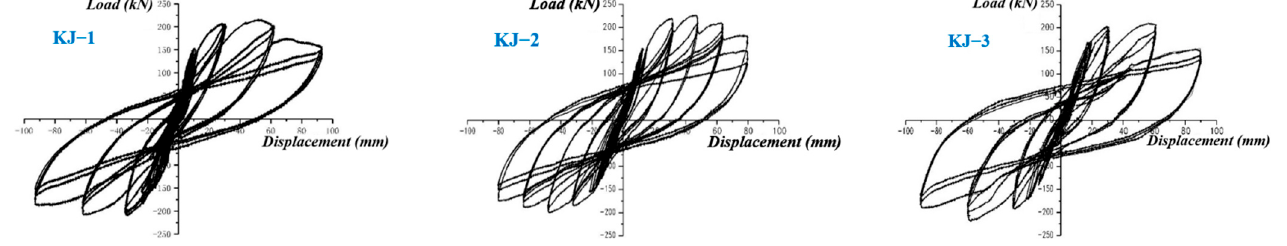
Figure 12. Load–displacement hysteresis loop.